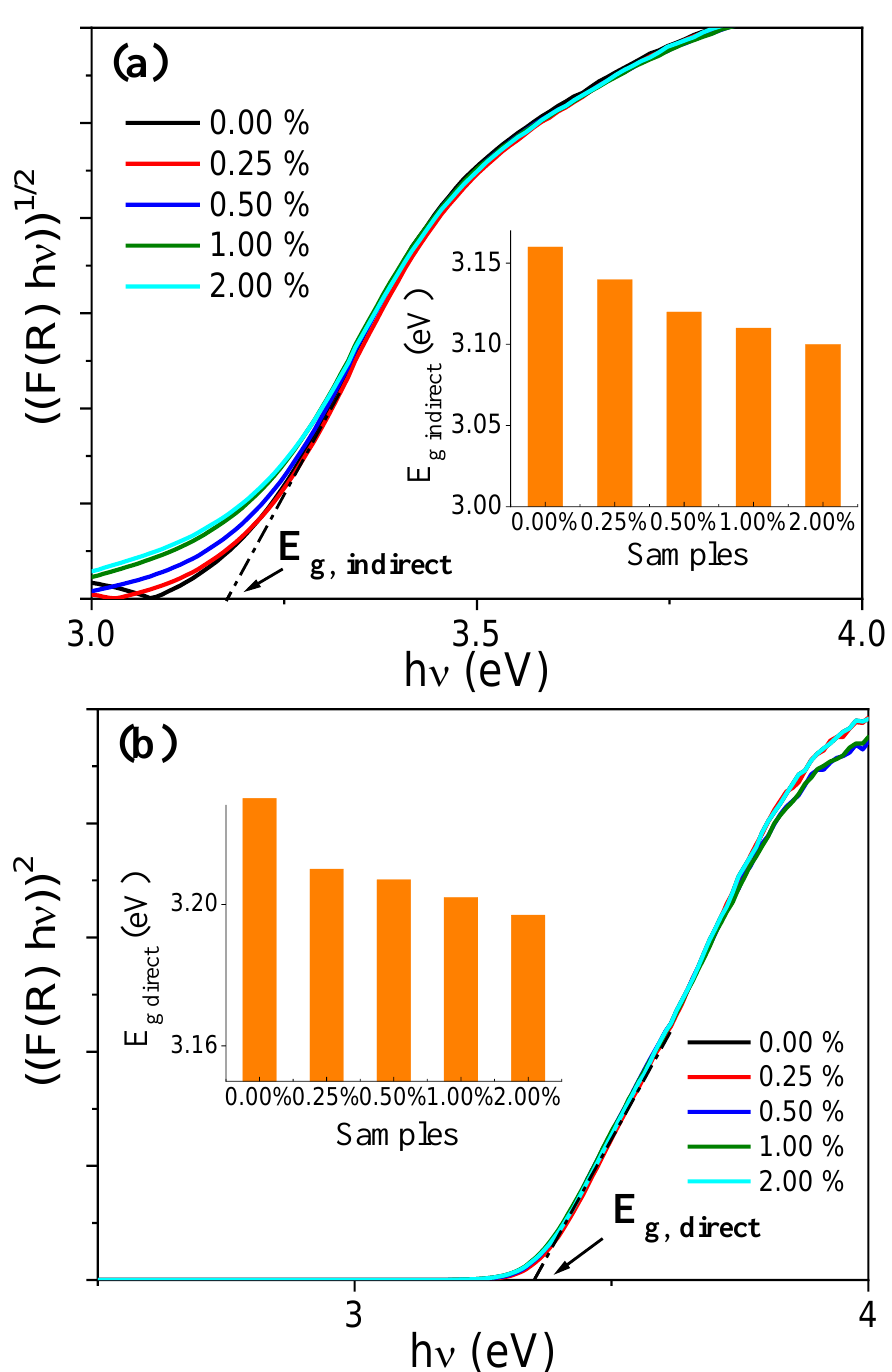
Figure 8. Determination of ( a ) the indirect bandgap and ( b ) the direct bandgap of Ce–Sm co-doped TiO 2 samples. Insets show the evolutions in the direct and indirect bandgap energies of TiO 2 versus Ce–Sm co-doping amounts.